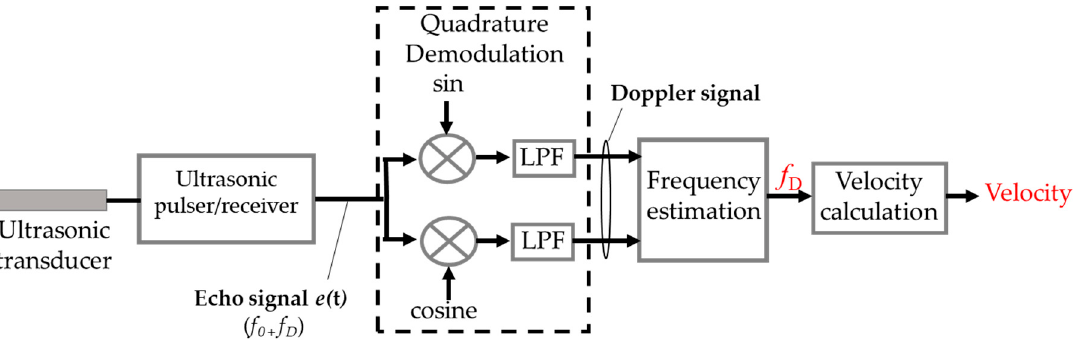
Figure 2 . Demodulation of the Doppler signal.